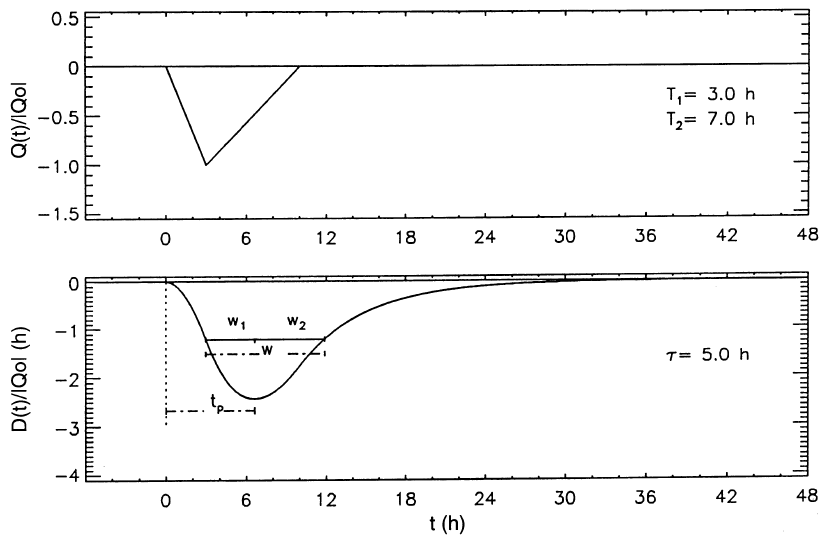
Fig. 3. The upper panel shows the triangu- lar normalized input function, Q (cid:133) t (cid:134) = j Q o j ; obtained for T 1 (cid:136) 3 h and T 2 (cid:136) 7 h (Eq. 7). The lower panel shows the corresponding response function, also normalized in j Q o j ; for s (cid:136) 5 h. As in Fig. 1, the characteristic times t p , w , w 1 and w 2 ; are shown in this plot